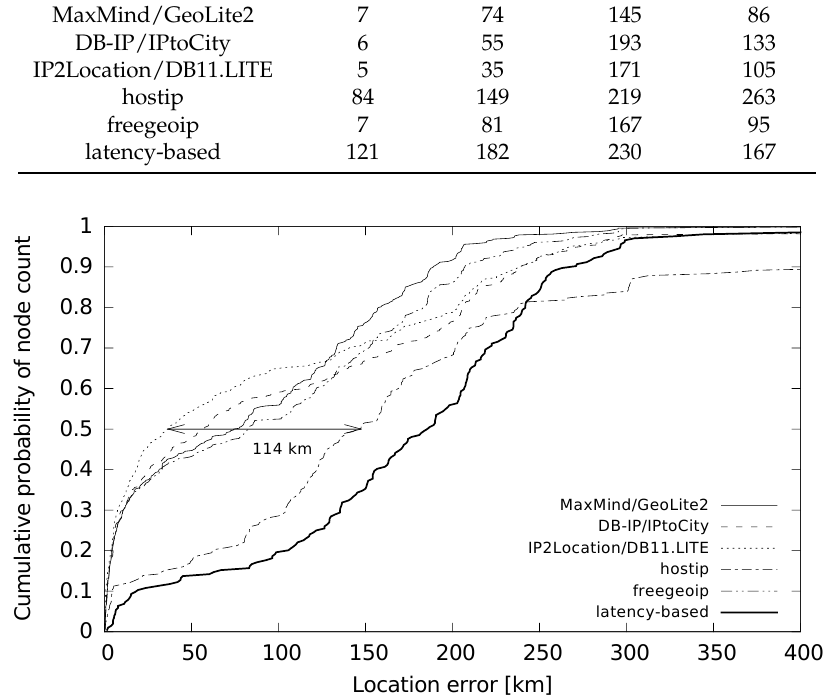
Figure 5. Location accuracy—distance errors.